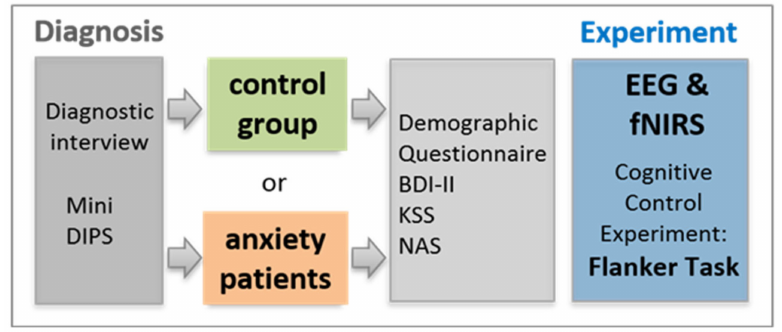
Figure 5. Experimental